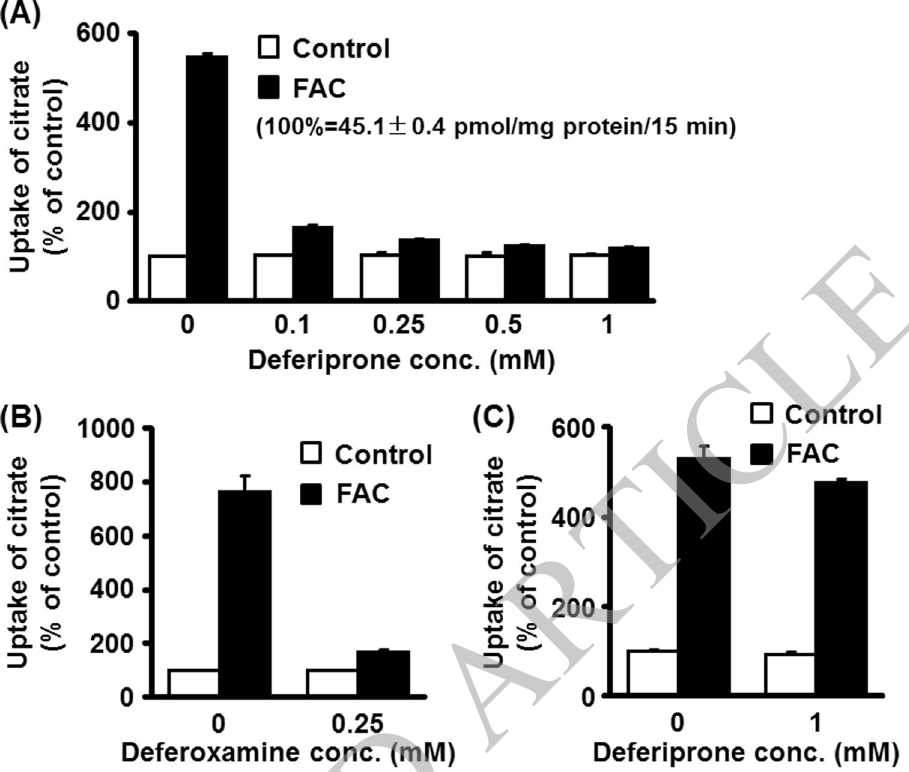
Figure 5. Effects of iron chelators on Fe 3 + -stimulated citrate uptake in FAC-treated HepG2 cells. HepG2 cells were cultured in the absence or presence of FAC (250 μ g/ml) for two passages. The cells were then seeded in 24-well plates and cultured in the absence or presence of FAC (250 μ g/ml) to confluence prior to uptake measurement. Uptake of [ 14 C]-citrate (3.5 μ M) was measured in a NaCl buffer, pH 7.5 for 15 min in the absence or presence of increasing concentrations of deferiprone, a cell-permeable iron chelator ( A ) or 0.25 mM deferoxamine, a cell-impermeable iron chelator ( B ). ( C ) HepG2 cells were cultured in the absence or presence of FAC (250 μ g/ml) for two passages. The cells were then seeded in 24-well plates and cultured in the absence or presence of FAC (250 μ g/ml) to confluence and then exposed to 1 mM deferoxamine prior to uptake measurement for 30 min. Uptake of [ 14 C]-citrate (3.5 μ M) was then measured in these cells in a NaCl buffer, pH 7.5 for 15 min in the absence of the iron